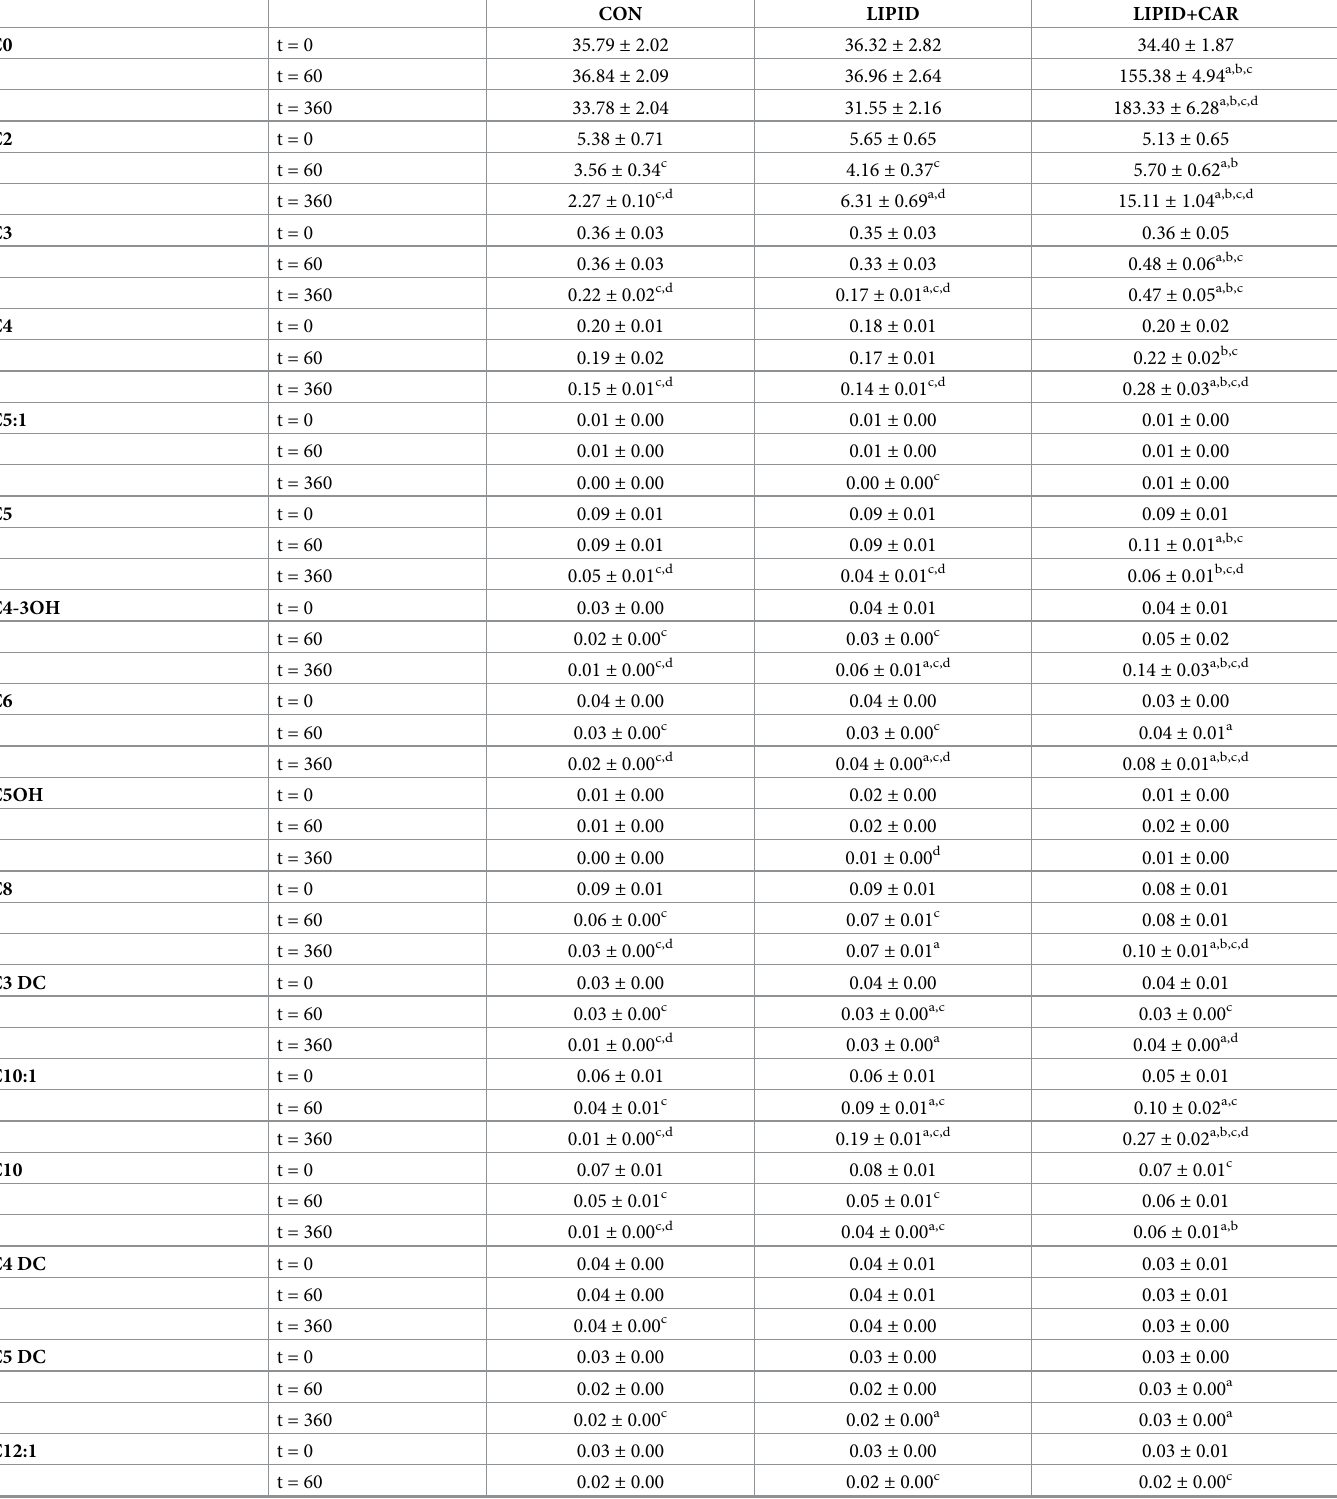
Table 3. Plasma acylcarnitine concentrations before, during and after the 6-hour hyperinsulinemic-euglycemic